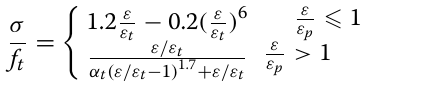
damage factor; = initial undam- = β the scale =